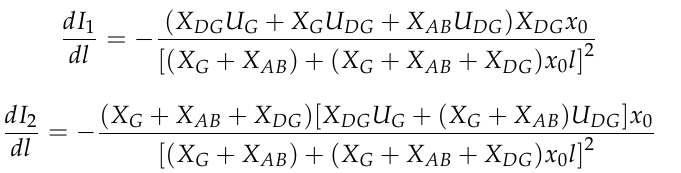
F 3 DG Figure 3. Diagram of distribution network with DG. + −